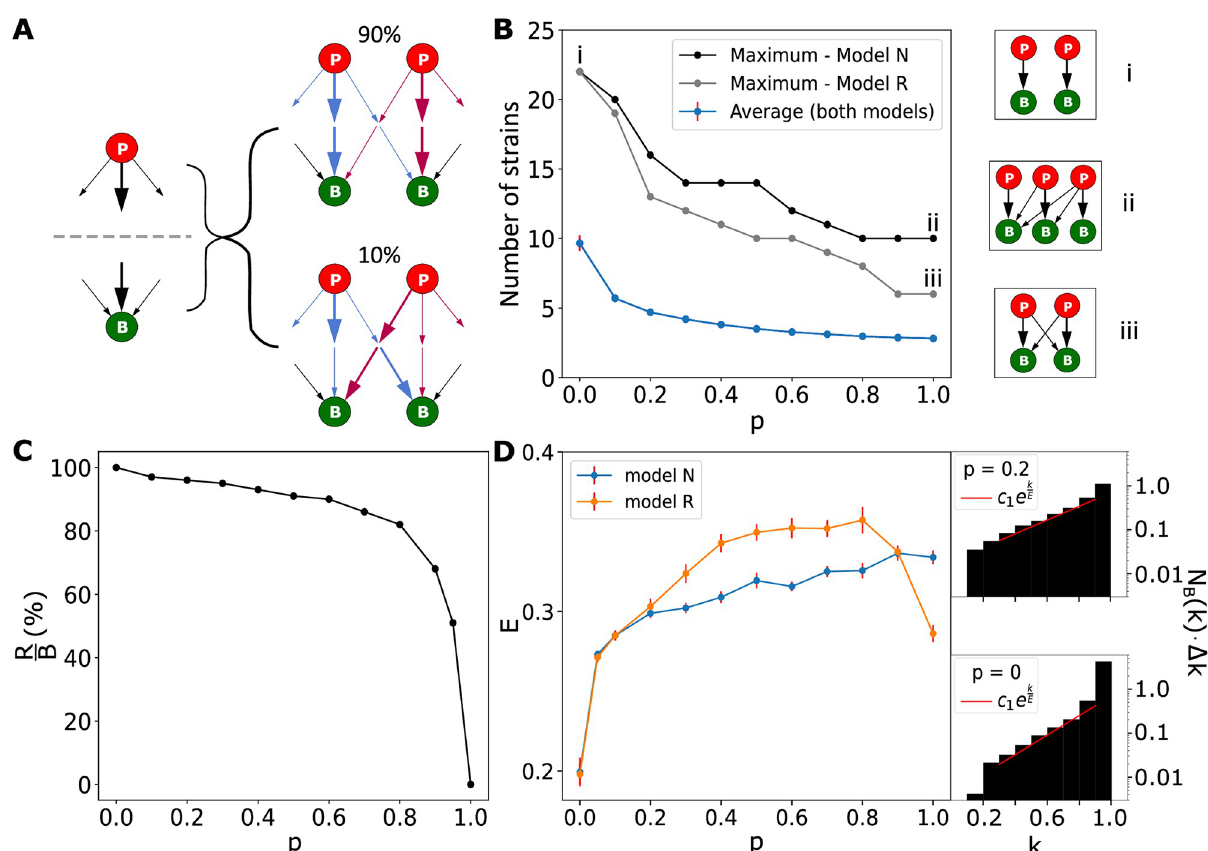
Fig 5. Analysis of evolved networks as a function of cross-link probability p . (A) Each phage (bacteria) has a number of links of different “strength” βη . In * 90% of stable ecosystems, the strongest links (bold arrows) from phage and to bacteria coincide for all strains, forming pairs. Different arrow colors correspond to different phages. (B) Average and maximal diversity obtained for 10000 additions to the system. The sub-panels show characteristic networks at the corresponding points. (C) Analysing events in Model R where a new bacterial strain leads to increased diversity. The panel show the fraction of these events where the new bacteria are resistant to all preexisting phages. (D) The Elimination factor E of fast to slow growers as a function of p . The side panels show how the elimination factor is obtained from the scaling of steady-state diversity with the growth rate k . Both side panels correspond to model R.